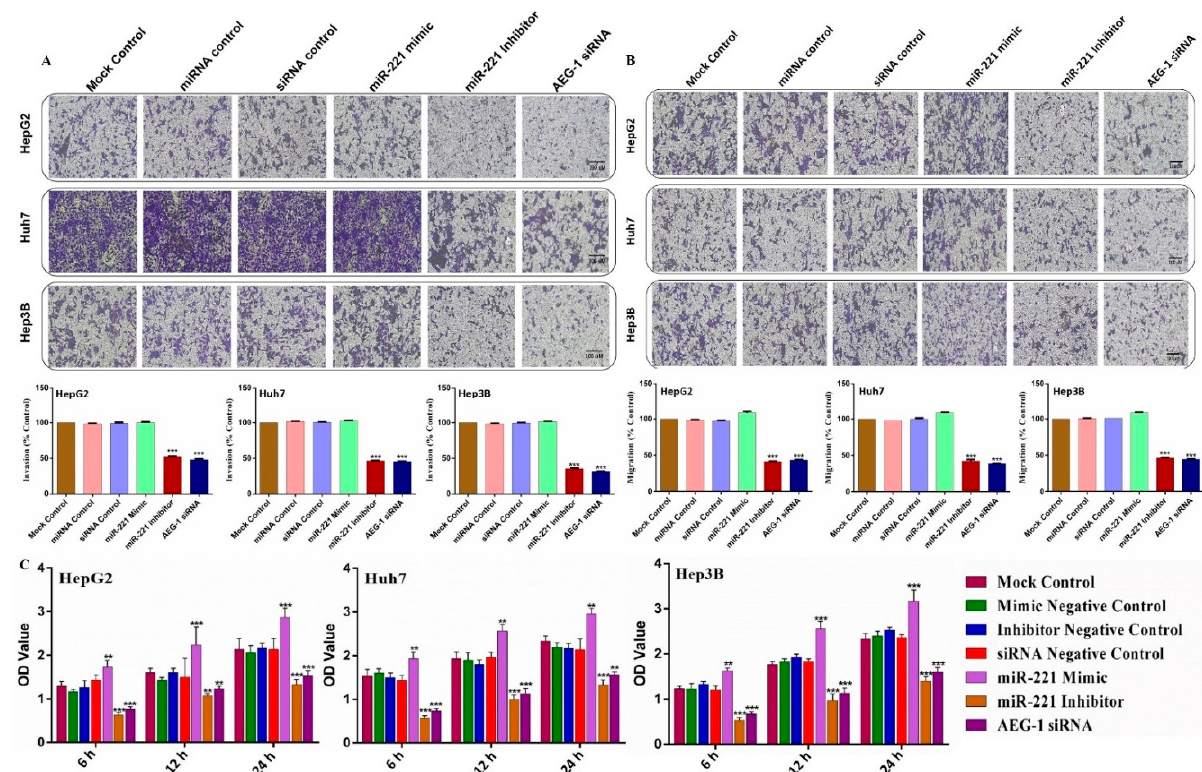
Figure 5. Silencing of AEG-1 and miR-221 inhibits HCC cell migration and proliferation in vitro. The effect of the miR-221/AEG-1 measured on HCC cell migration and cell proliferation in the miR-221 mimic-, miR-221 inhibitor-, AEG-1 siRNA-, and their control-transfected HepG2, Huh7, and Hep3B cells by invasion ( A ), migration ( B ), and MTT assay ( C ) in vitro. Images analyzed using Image J (NIH) (scale bar, 100 µ m). Error bars presented as mean ± s.d and p -value represented as ** p < 0.01, *** p < 0.001 compared to the corresponding controls.